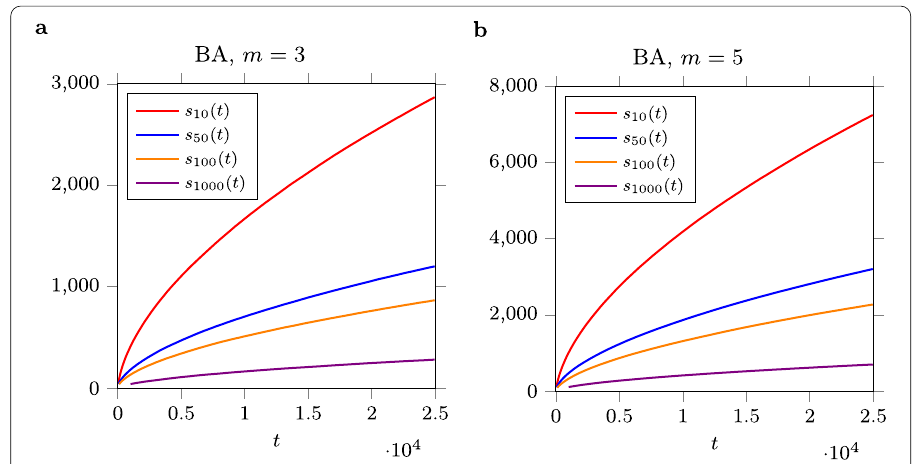
Fig. 5 Evolution of sum of neighbors’ degrees in networks generated by Barabási–Albert model for selected nodes v i , i = 10,50,100,1000 , as t iterates up to 25000. Network in the figure a is modeled with m = 3 while in b is simulated with m =